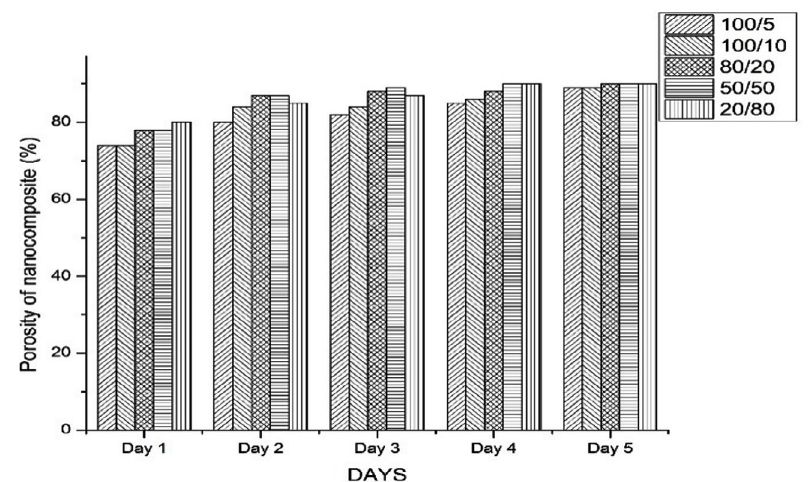
Fig. 1. Porosity (in %) of nanocomposite with different ratios of Chitosan/